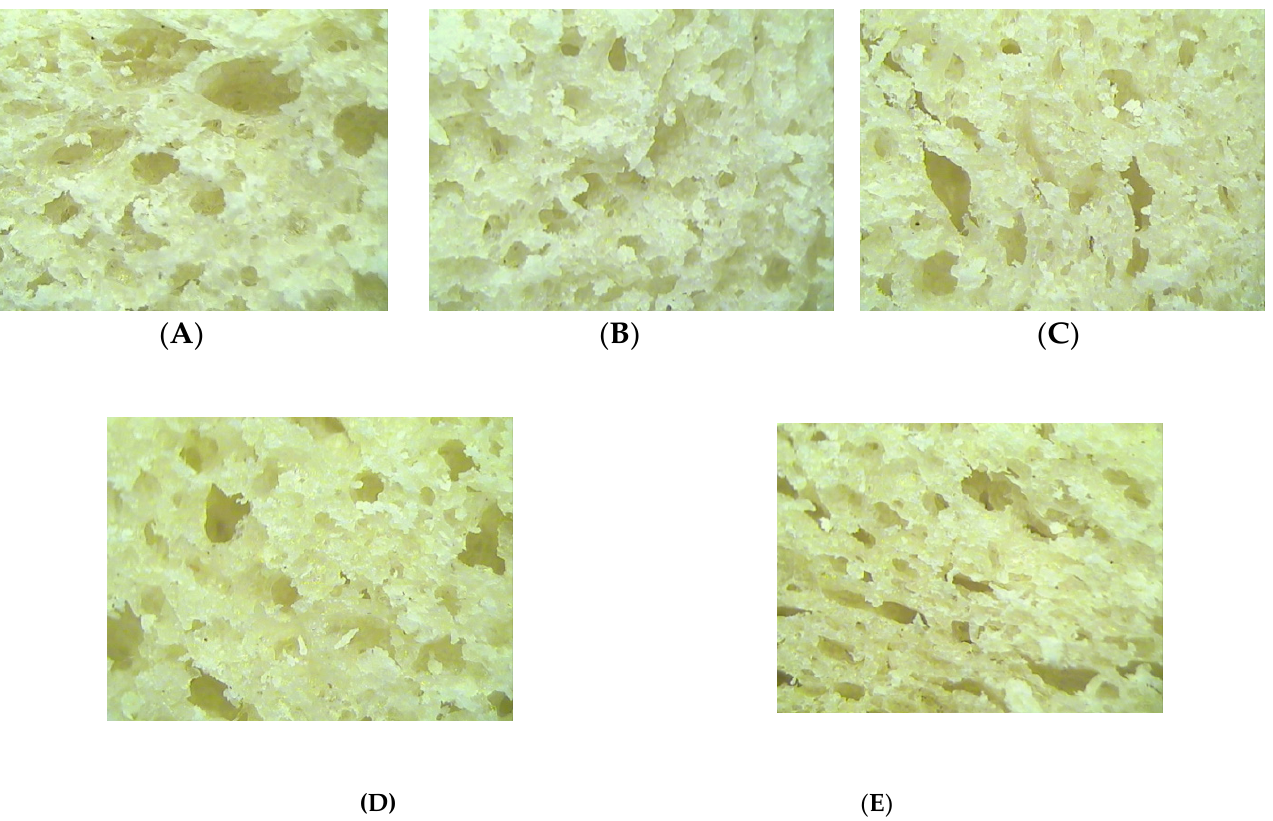
Figure 4. Structure of wheat dough with germinated chickpea flour (GCF) at different levels: 0% ( A ), 5% ( B ), 10% ( C ), 15% ( D ) and 20% ( E ).